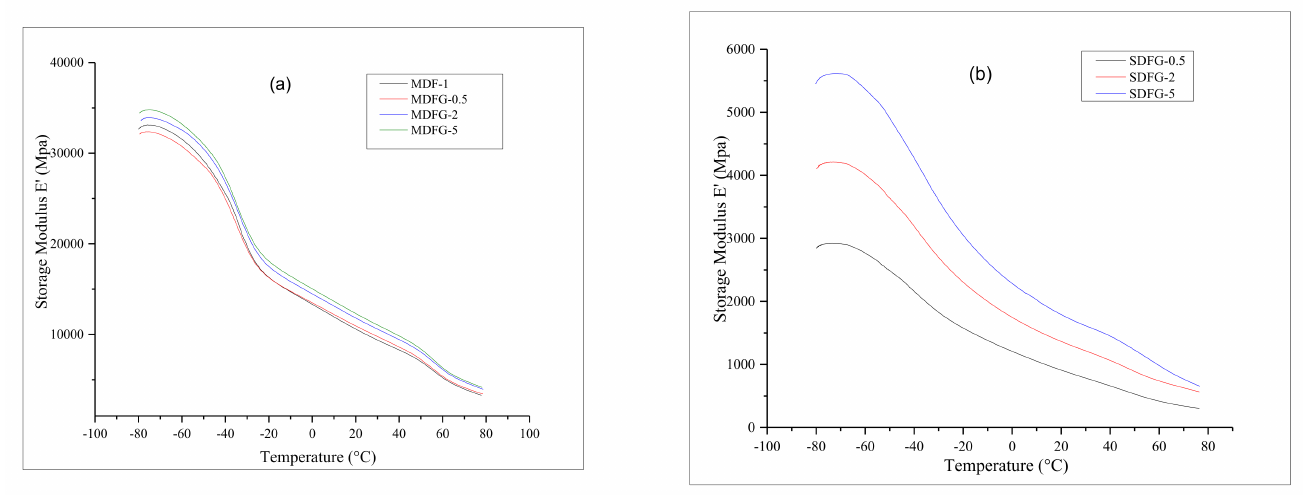
Figure 3. ( a ) Overlay graphs of storage modulus of nanocomposites prepared by melt-mix method and ( b ) prepared by solution-cast